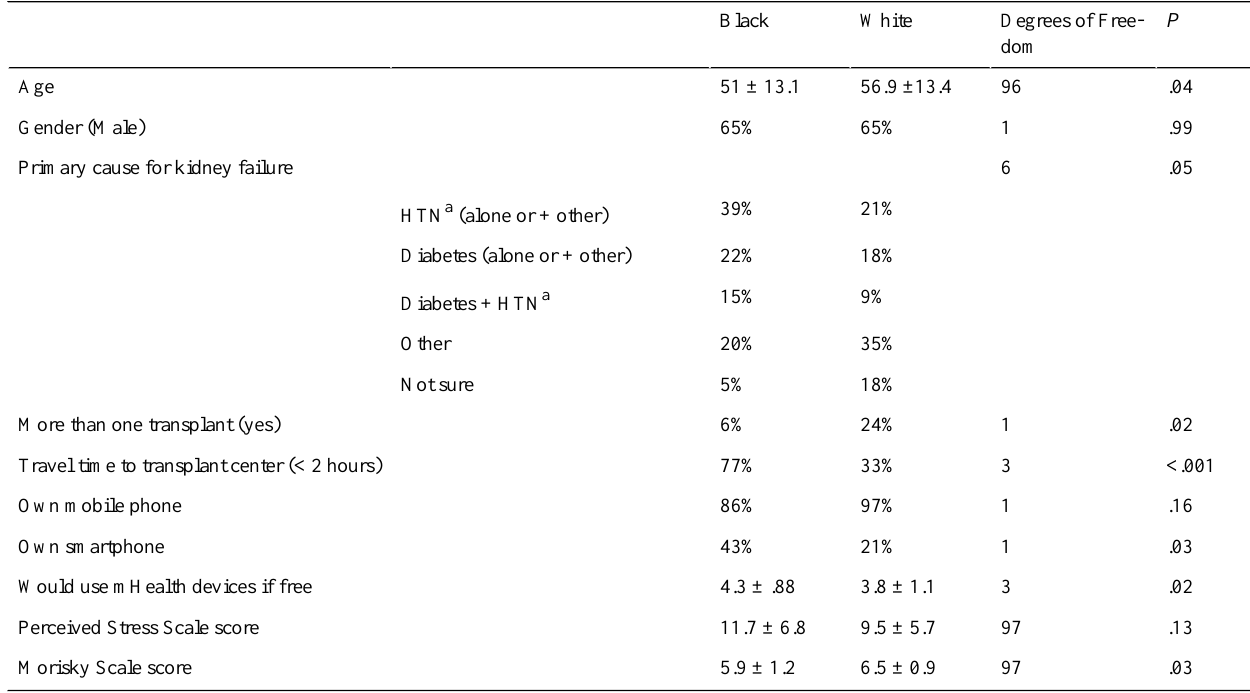
Table 3. Race comparison on transplant related characteristics, stress exposure, medication adherence and cell phone ownership.